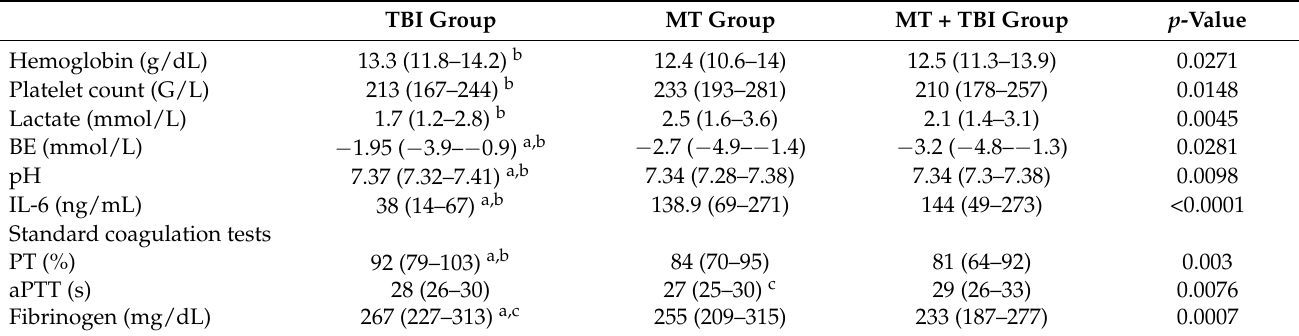
Table 2. Laboratory data measured upon ER